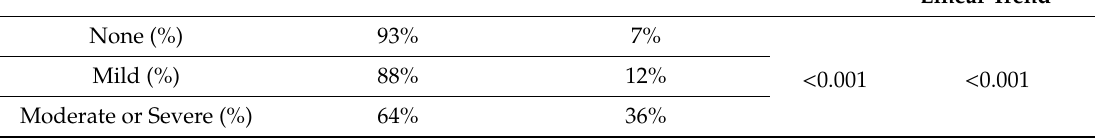
Table 2. Prevalence of atrial fibrillation detection on 24-h Holter monitoring stratified by degree of left atrial enlargement. Left Atrial Enlargement Atrial Fibrillation ( − ) Atrial Fibrillation ( + ) p -Value *